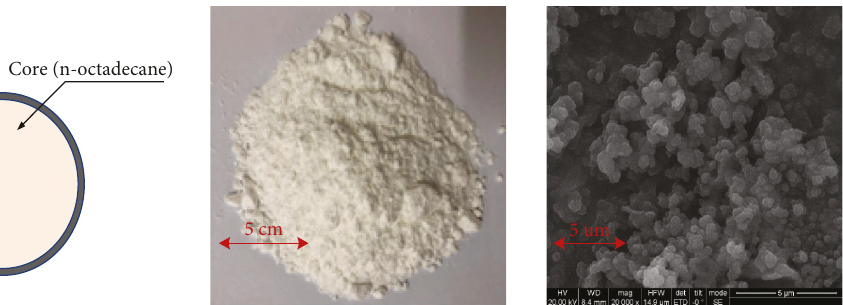
Figure 1: Morphology picture of MPCM.